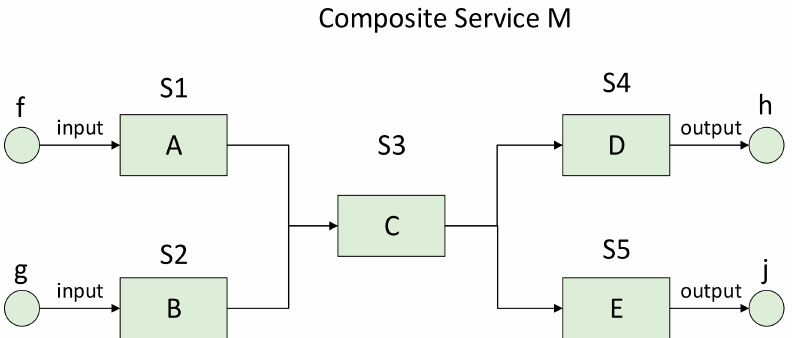
Figure 3. Geospatial composite service. The figure shows the geospatial composite service M, while the rectangle represents the atomic service and the circle represents the parameter. The arrow indicates the direction of parameter transfer. M’s input parameter is the union of the input parameters of the atomic services A (S1) and B (S2); that is, (S1.f, S2.g). M’s output parameter is the union of the output parameters of the atomic services D (S4) and E (S5), i.e., (S4.h,